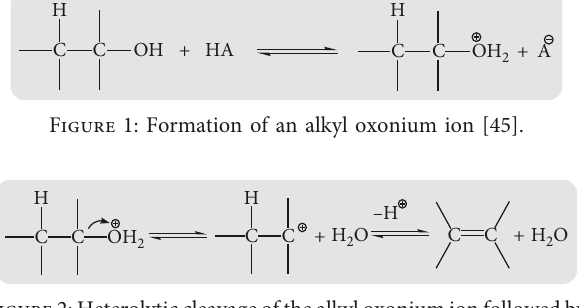
Figure 2: Heterolytic cleavage of the alkyl oxonium ion followed by olefin formation [46,